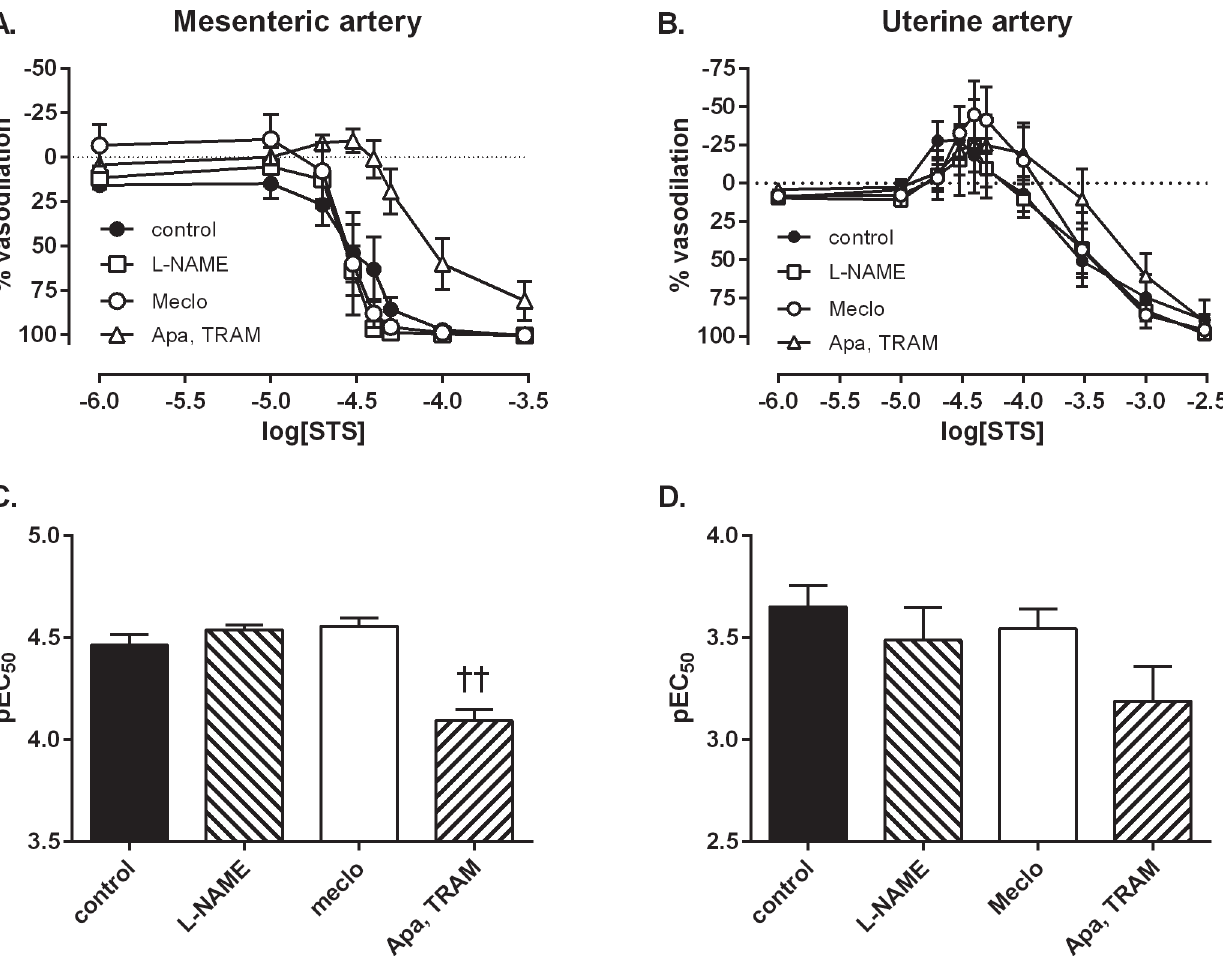
Fig 2. Involvement of endothelium-dependent vasodilator mechanisms in direct STS responses. Mechanisms of vascular responses to STS in mesenteric (A&C) and uterine (B&D) arteries from the pregnant rat (GD 10.9 ± 0.2). Vasodilator responses to STS in the absence (closed circles) or presence of inhibitors of nitric oxide synthase (NOS) ( N -nitro-L-arginine methyl ester hydrochloride, L-NAME, 100 μ mol/l, open squares), cyclooxygenase (meclofenamate, 1 μ mol/l, open circles) or a combination of apamin (100 nmol/l) and TRAM-34 (10 μ mol/l) which block SK Ca and IK Ca channels respectively (open triangles) in A: mesenteric arteries and B: uterine arteries. Sensitivity (negative log of the effective concentration producing 50% of the maximal response) of vascular responses to STS in C: mesenteric arteries or D: uterine arteries. Data analysed by one-way ANOVA with a Bonferroni post-test; †† : p < 0.01 vs. control vessel. Mesenteric: control n = 8; L-NAME n = 6; Apa, TRAM n = 7; Meclo n = 4. Uterine: control n = 10; L-NAME n = 6; Apa, TRAM n = 7; Meclo n = 5.